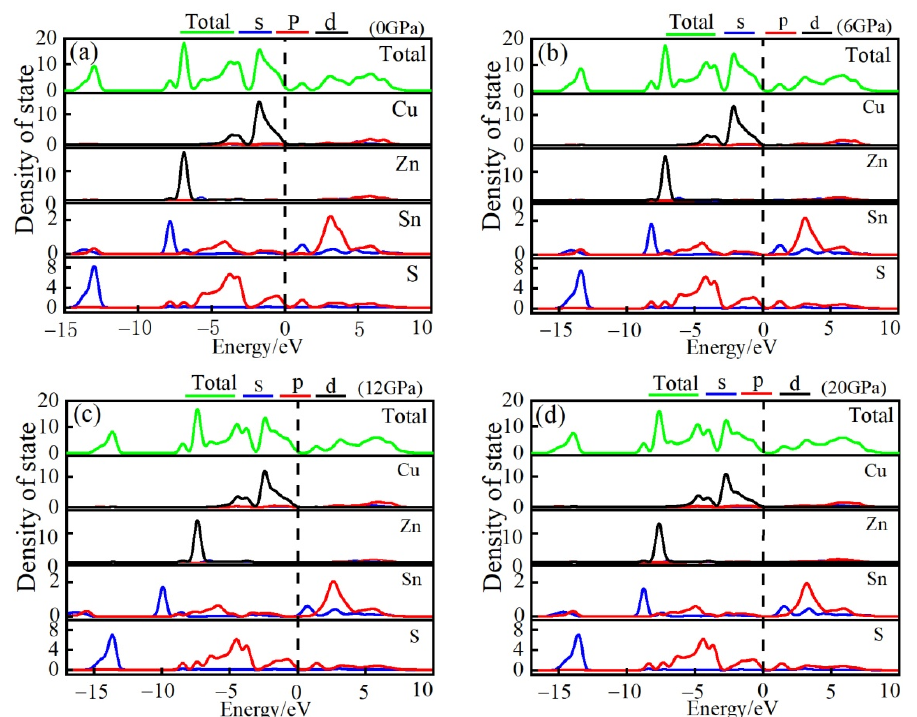
Figure 5. Cu 2 ZnSnS 4 density of states under compressive stressfor ( a ) 0 GPa density of states and fractional density of states; ( b ) 6 GPa density of states and fractional density of states; ( c ) 12 GPa density of states and fractional density of states; ( d ) 20 GPa density of states and partial wave density of states.